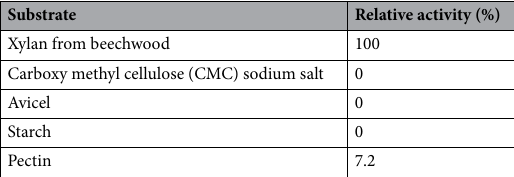
Table 4. Substrate specificity of purified xylanase enzyme.